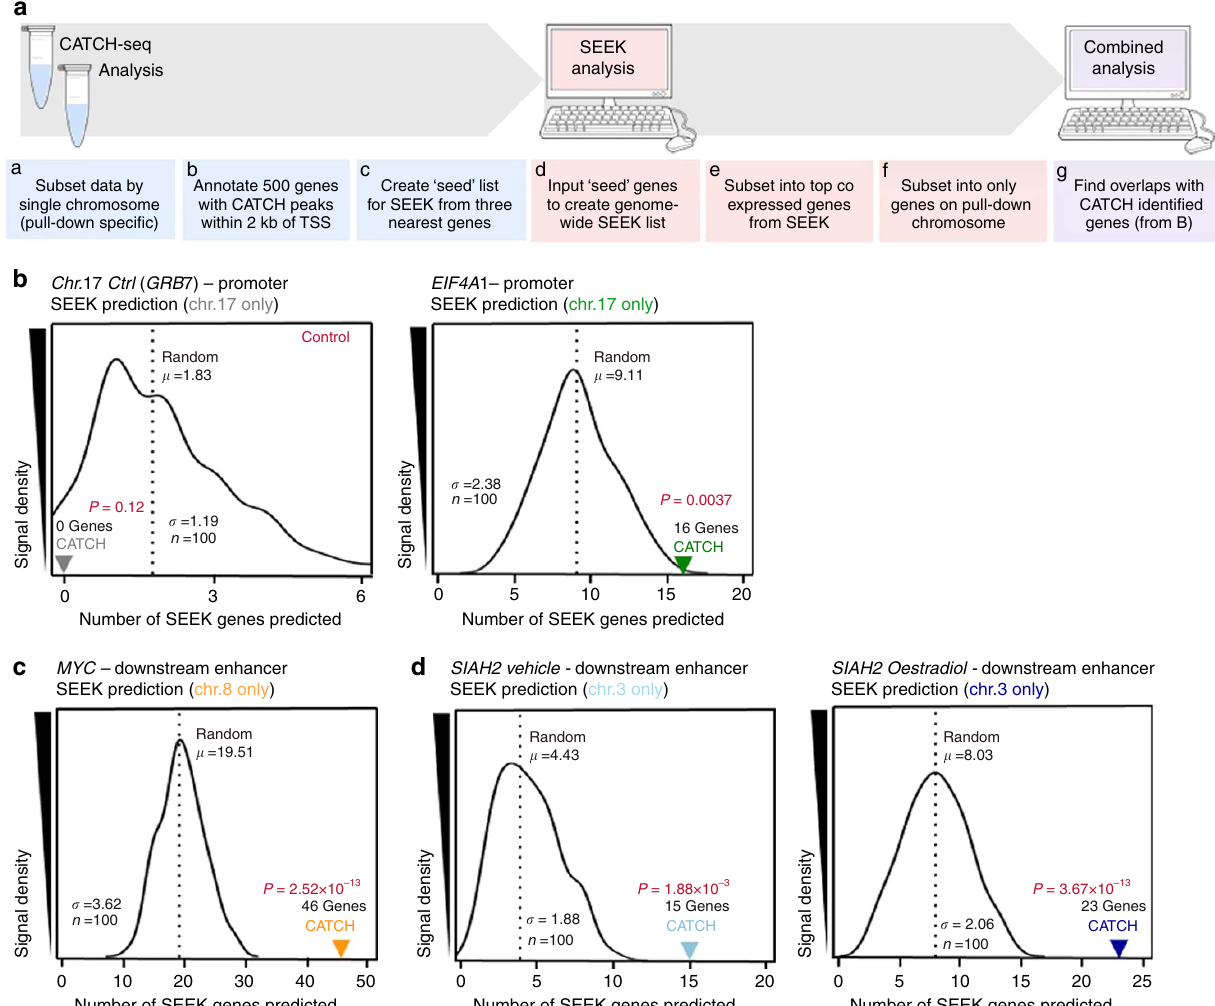
Figure 5 | Finding CATCH-seq interactions at gene promoters predicts transcriptional coexpression. ( a ) Graphic outlining the general processing and data analysis that assess the ability of CATCH interactions to predict SEEK coexpressed genes. ( b ) Histogram representing the number of SEEK genes ‘predicted’ at random, or by specific CATCH-seq (left, grey: GRB7 negative control; right, green: EIF4A1 promoter). ( c ) Histogram representing the number of SEEK genes ‘predicted’ at random, or by specific CATCH-seq (orange: MYC downstream enhancer). ( d ) Histogram representing the number of SEEK genes ‘predicted’ at random, or by specific CATCH-seq (left, light blue: SIAH2 –vehicle; right, dark blue: SIAH2 –oestradiol). In each experimental case, CATCH was capable of significantly predicting SEEK coexpression over random. All analyses were restricted to the specific chromosome of the CATCH pulldown. P values were calculated via t